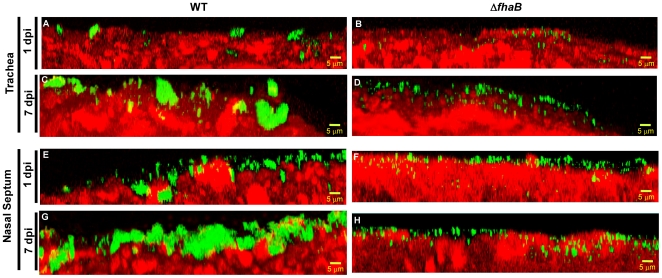
Immunofluorescence microscopy analysis of B. pertussis biofilm formation within the murine respiratory tract.Groups of 6-week-old C57BL/6 mice were intranasally inoculated with 50 µl containing 5×105 CFUs of either the WT or ΔfhaB strain grown under Bvg+ phase conditions. Sections of trachea and nasal septum were harvested at 1 or 7 days post-infection from infected animals, immediately fixed, and probed with rat anti-Bordetella serum followed by a donkey anti-rat secondary antibody conjugated to Alexa Flour 488 (which stains bacteria green). To determine the localization of the host epithelium, specimens were stained for F-actin using phalloidin conjugated to Alexa Fluor 633 (which stains the epithelium red). For visualization with CLSM, those tissues corresponding to infected animals that showed similar levels for colonization by the WT and the ΔfhaB mutant were chosen. For each specimen, image stacks were obtained from at least ten areas of the trachea and nasal septum. (A–H) Each micrograph is a Z reconstruction produced from a representative stack of Z-section images.